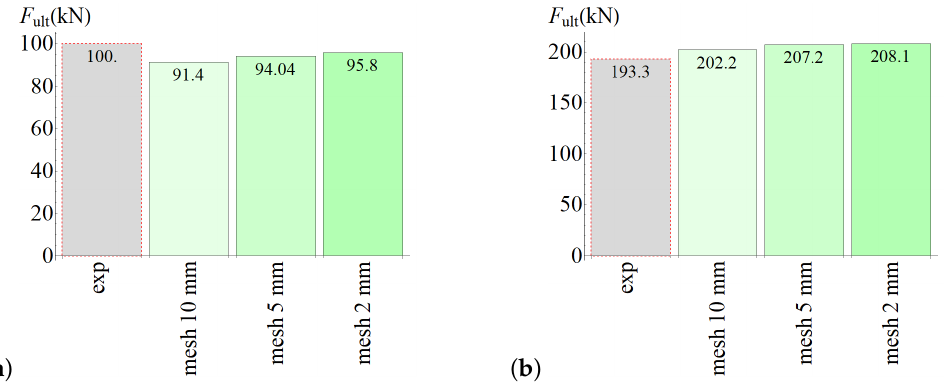
Figure 15. ( a ) Results of the splitting test simulation. ( b ) Results of the slant-shear test